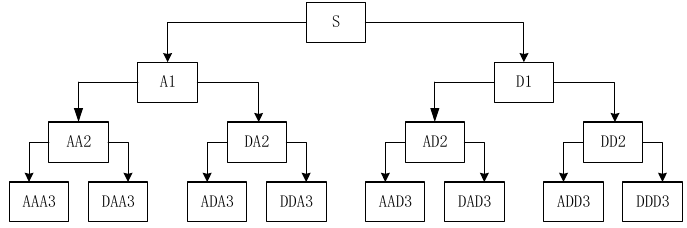
Figure 2. Wavelet Packet Signal Decomposition Diagram.